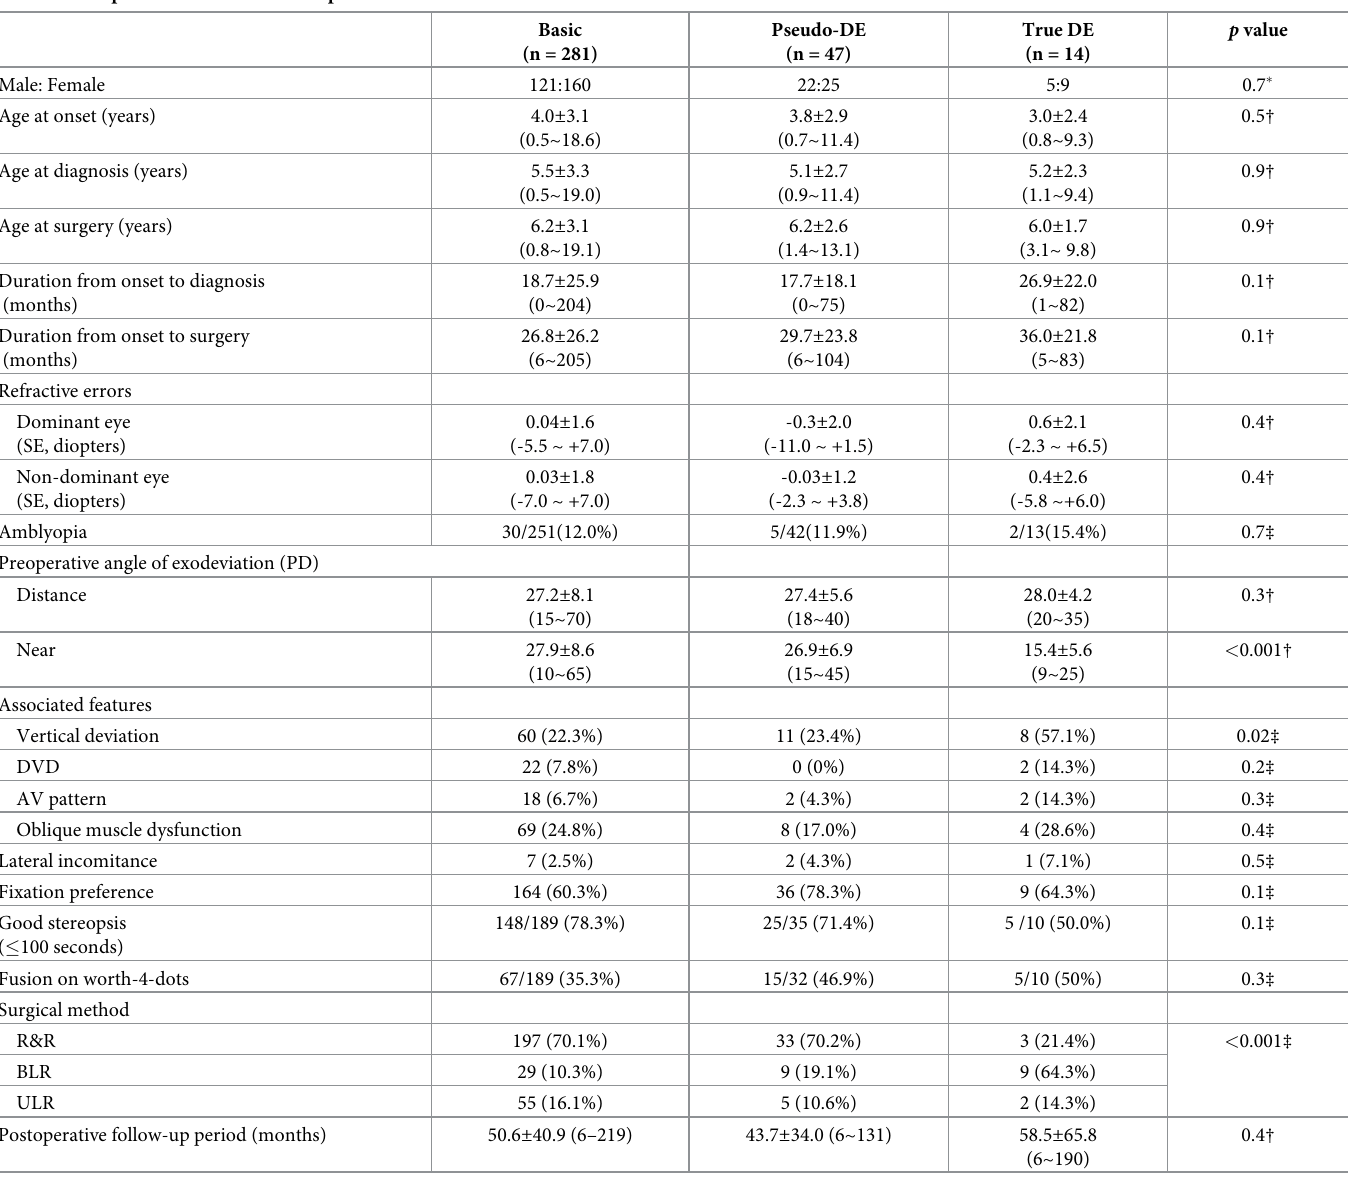
Table 2. Preoperative characteristics of